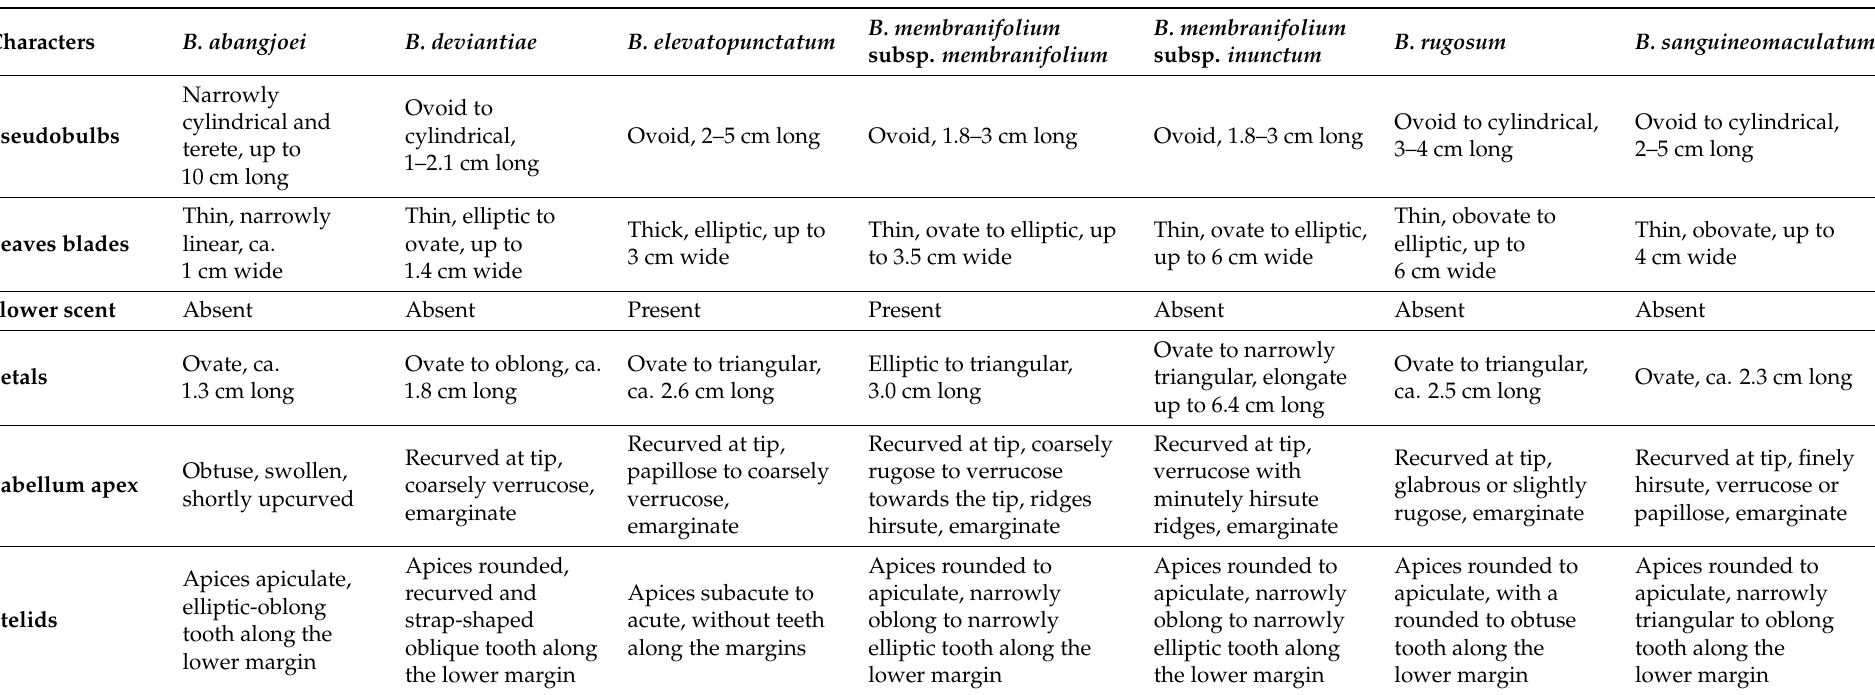
Table 1. Comparison of morphological characters of one-flowered Bulbophyllum sect. Beccariana ‘Group D fide [4]’ from Borneo and